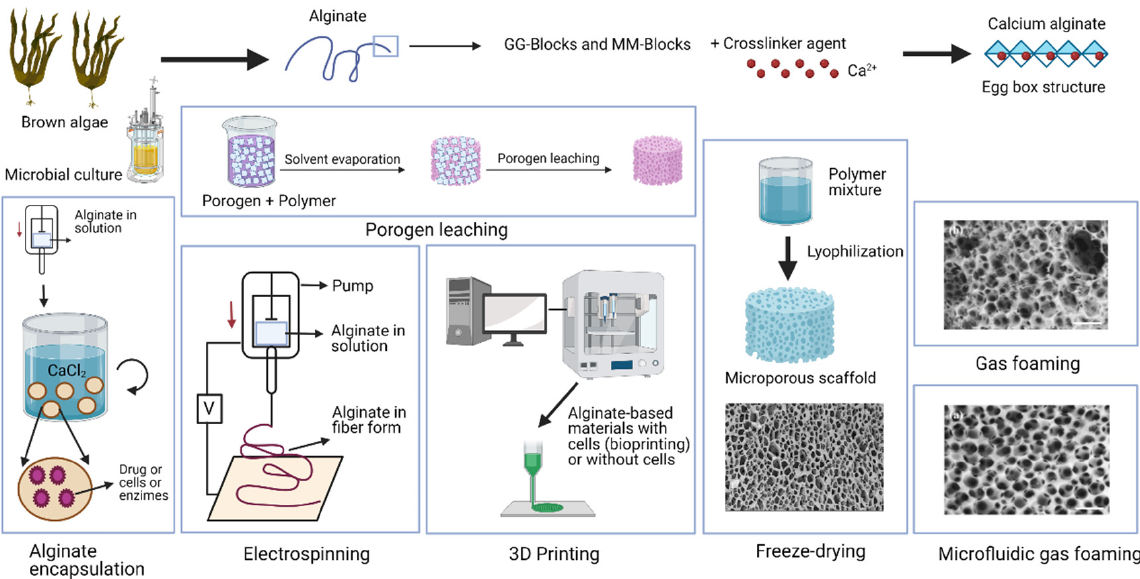
Figure 8. Summary illustration of extraction, crosslinking, central alginate manipulation, encapsu- lation, and scaffold formation techniques, such as electrospinning, 3D printing, freeze-drying, gas foaming, microfluidic gas foaming, and the porogen leaching technique. Created with BioRen-